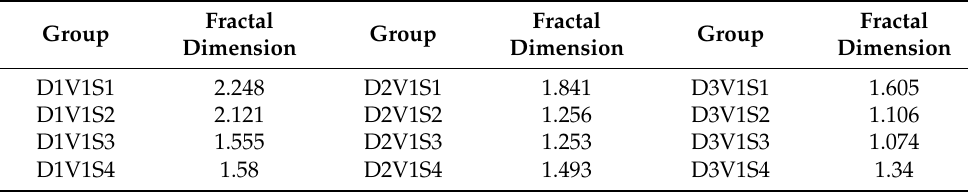
Table 5. The fractal dimension of V1 test group.